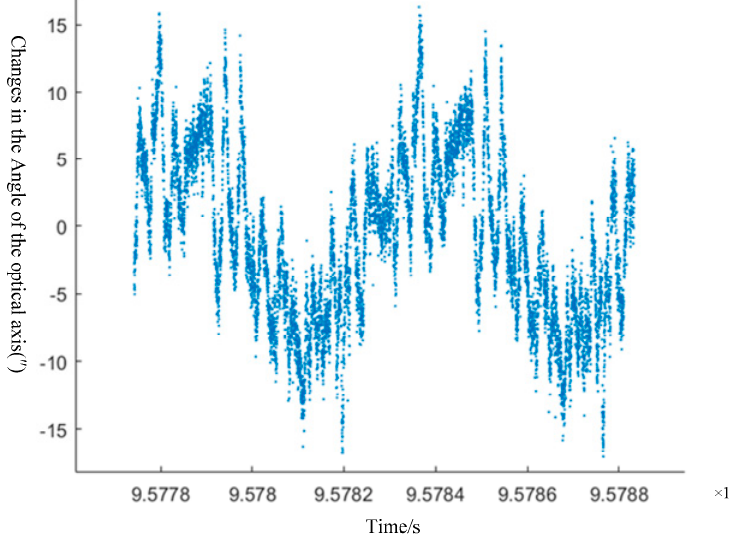
Figure 10. The variation in the angle of the star-sensitive optical axis.